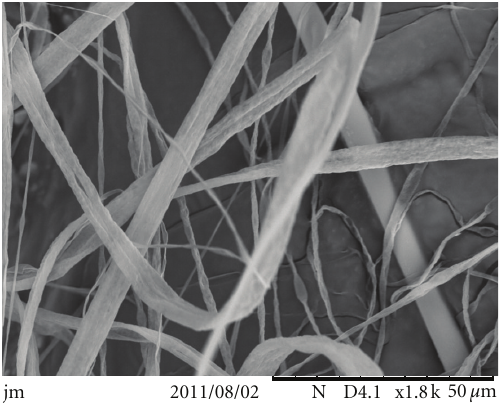
Figure 3: SEM image of 2% PFMOP nanofibers.